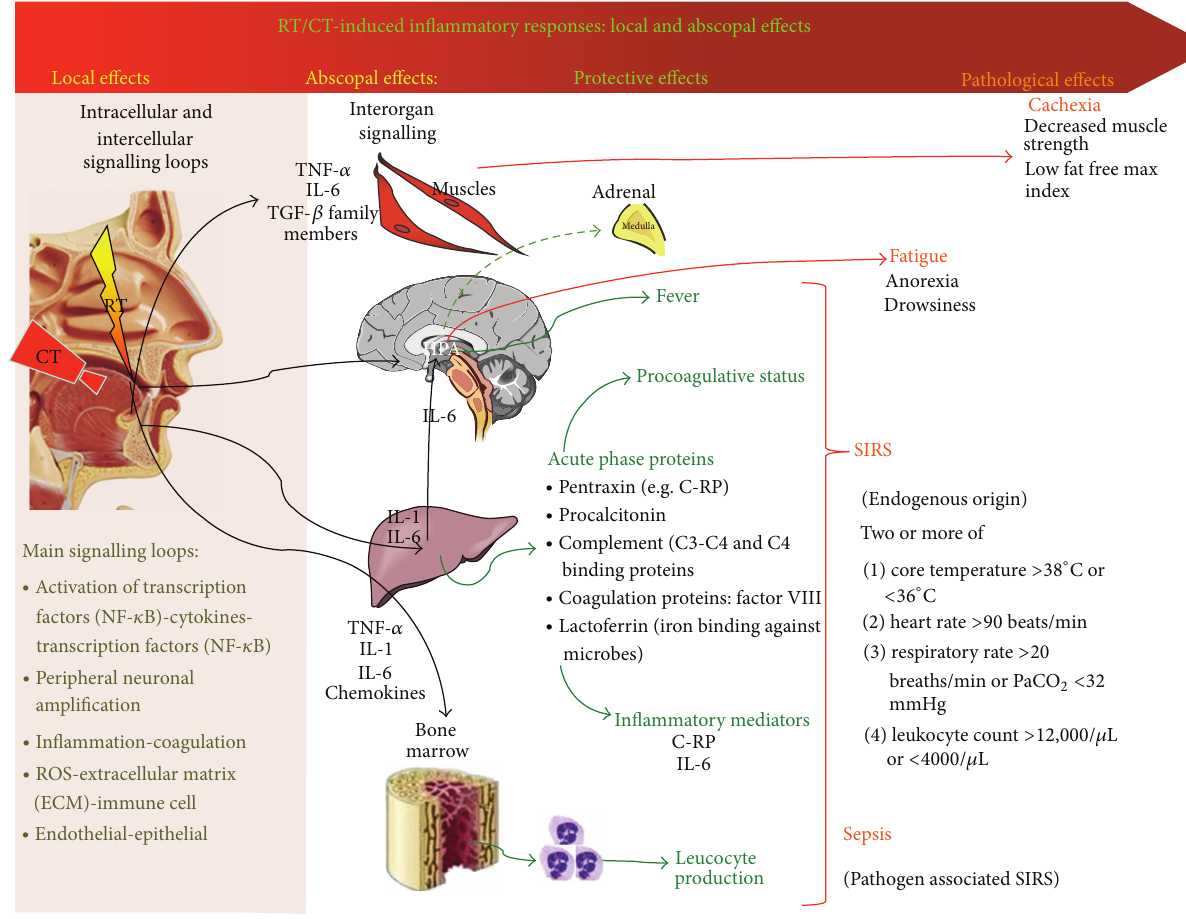
Figure 1: RT/CT-induced inflammatory responses: local and abscopal effects. Intracellular and intercellular signalling loops follow initiation and upregulation due to the local effects of chemoradiation on the exposed tissues. Released cytokines act not only locally but also on other organsandtissues(Interorgansignalling).Onmusclestheycanalterenergeticmetabolism(thusfavouringcachexia).OnHPA(hypothalamic- pituitary-adrenal axis) they cause fever and fatigue symptoms. In the liver they provoke the synthesis of acute phase proteins that in turn act in a procoagulative and general inflammatory and antiinflammatory sense. All these effects can lead to systemic inflammatory response syndrome (SIRS) or sepsis. Abbreviations: PaCO 2 : arterial carbon dioxide tension. For other abbreviations, see the